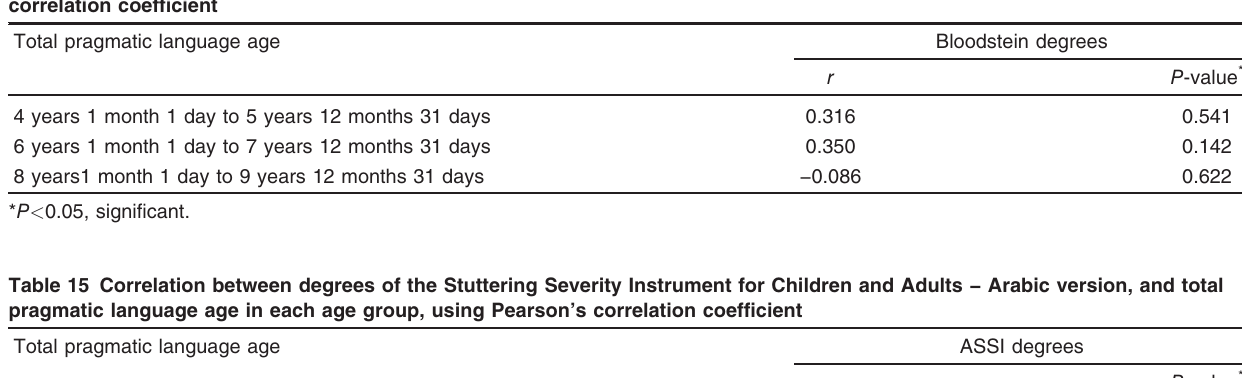
Table 14 Correlation between Bloodstein degrees and total pragmatic language age in each age group using Pearson ’ s